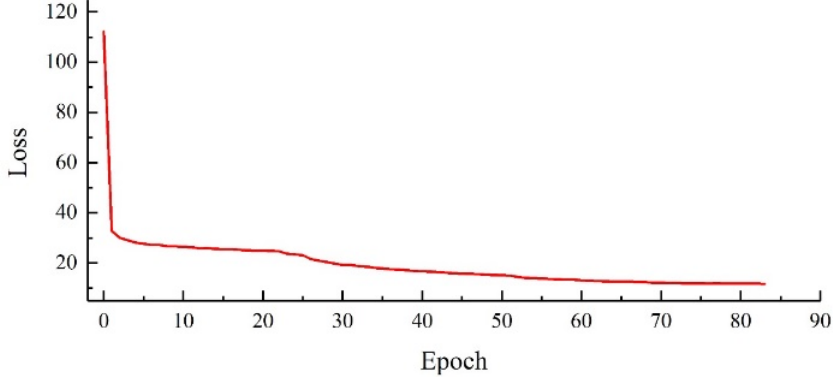
probability that the detection object is a sugarcane stem node. Figure 5 shows the total loss function curve during training. In the initial training stage of the sugarcane stem node detection model, the model learning efficiency was high, and the training converged fast. With the deepening of the training, the slope of the training curve decreased gradually. When the number of training iterations reached 80, the model learning gradually stabilised.